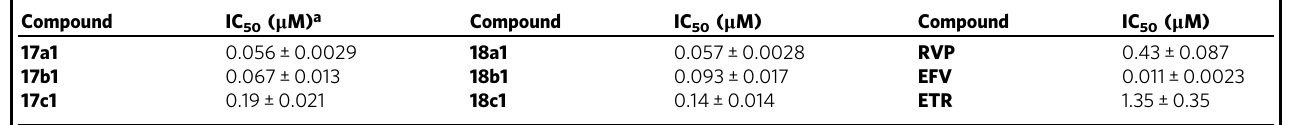
Table 3 Inhibitory activity against WT HIV-1 RT.